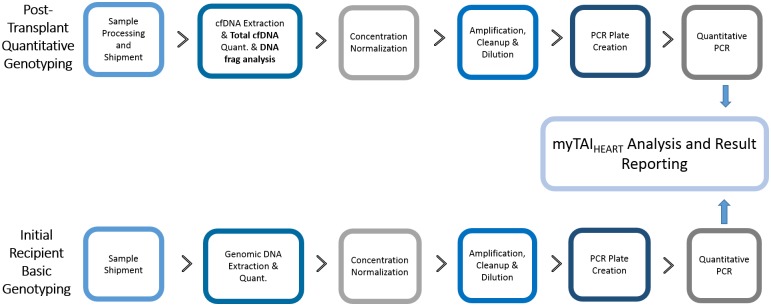
myTAIHEART clinical testing workflow schematic.